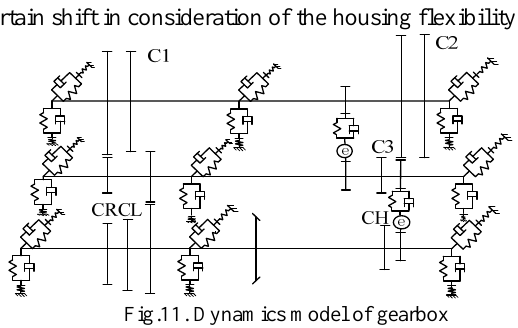
Fig.11. Dynamics model of gearbox